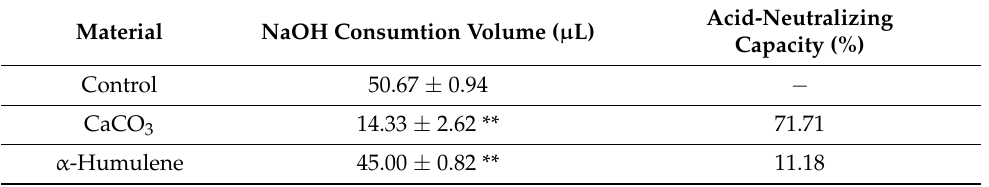
Table 2. Acid-neutralizing capacity of α